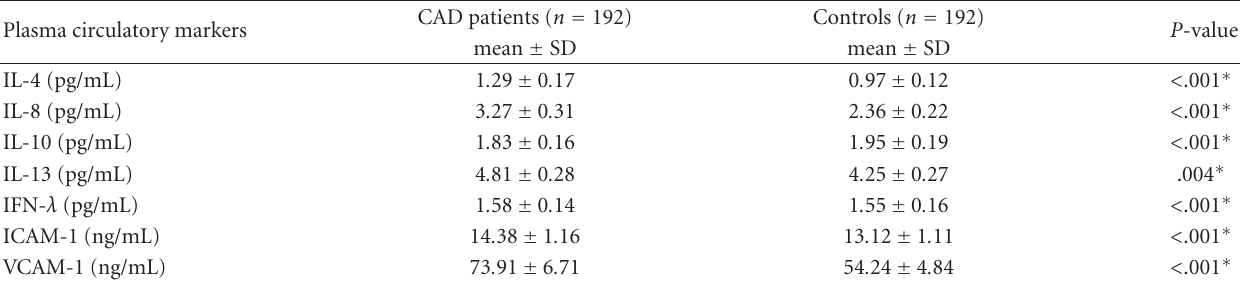
Figure in parenthesis indicates % positivity. Table 2: Evaluation of plasma circulatory markers in coronary artery disease patients and controls. Plasma circulatory markers